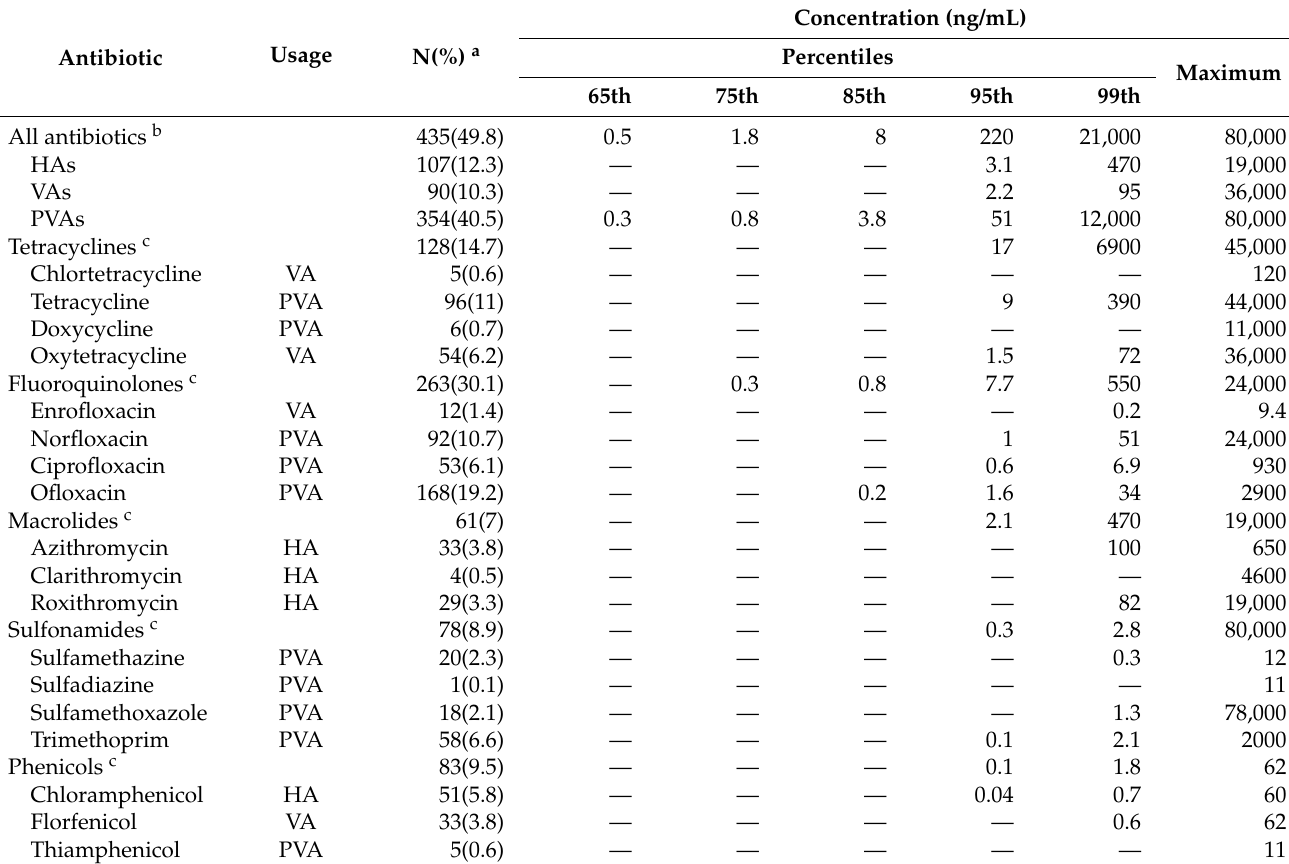
Table 1. Detected Frequency and Concentration Distribution of Antibiotics in the Urine of Adults in Xinjiang ( n =